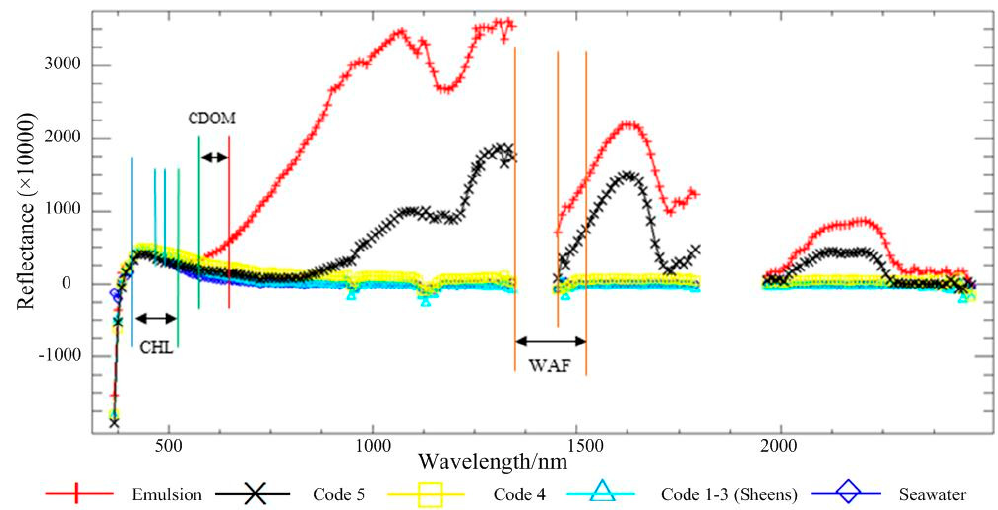
Figure 17. Bands used for seawater spectral indices. Red, black, yellow, cyan, and blue lines represent emulsions, oil slicks of code 5, oil slicks of code 4, oil slicks of code 1–3, and seawater, respectively.